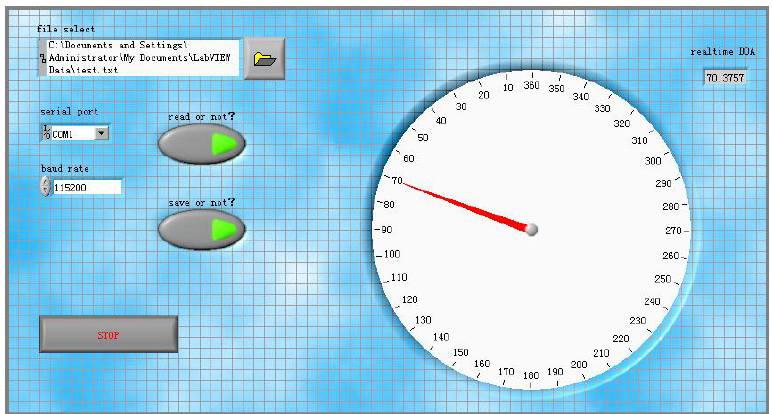
Figure 4. User interface of real-time DOA by